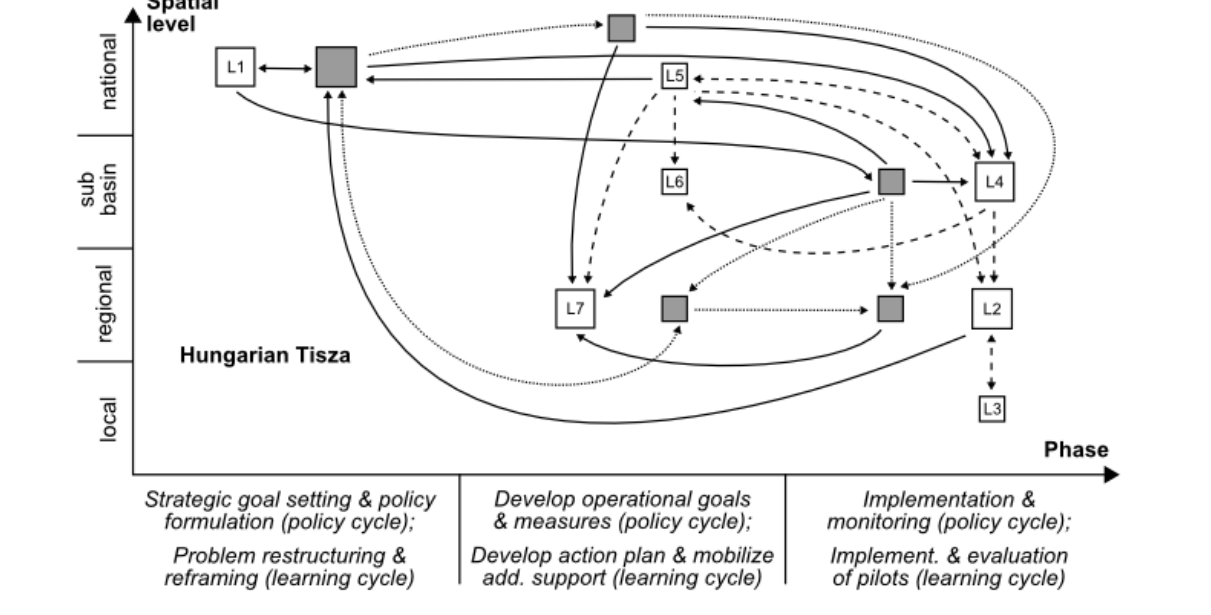
Fig. 3 . Formal policy and informal learning processes and their interdependencies in the Hungarian Tisza. See Figure 2 for detailed explanations of the notations and Figure A1 in Appendix 1 for the nonaggregated version, in which each individual action situation (AS) and all phases are